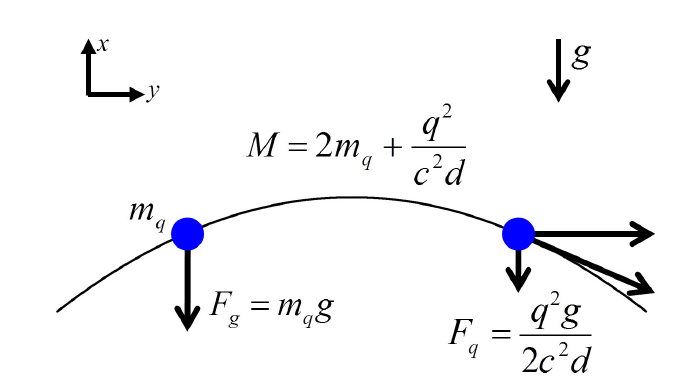
Figure 3. Charged dumbbell. Two identical charged particles (blue points) in a gravitational field weigh more than the sum of their constituents. The excess mass, (cid:1869) (cid:2870) (cid:1855) (cid:2870) (cid:1856)⁄ , follows from the energy mass equivalency. Boyer provided a force picture where the force due to curved field lines gives the same mass [5]. Only the field line connecting the two particles is depicted here. Each charge experiences both the downward gravitational force and the downward electric